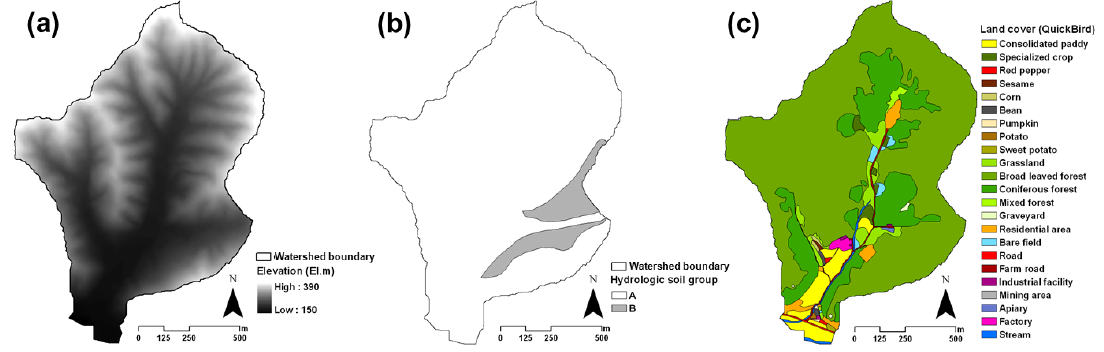
Figure 3. GIS data: ( a ) elevation, ( b ) hydrologic soil group and ( c ) land use [2].